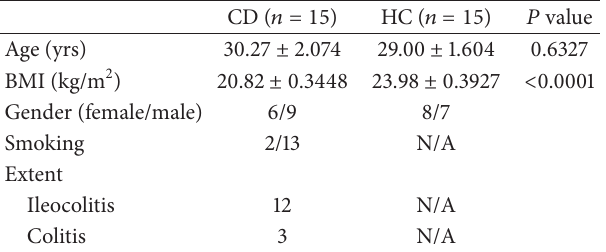
Table 1: Characteristic of included CD patients and